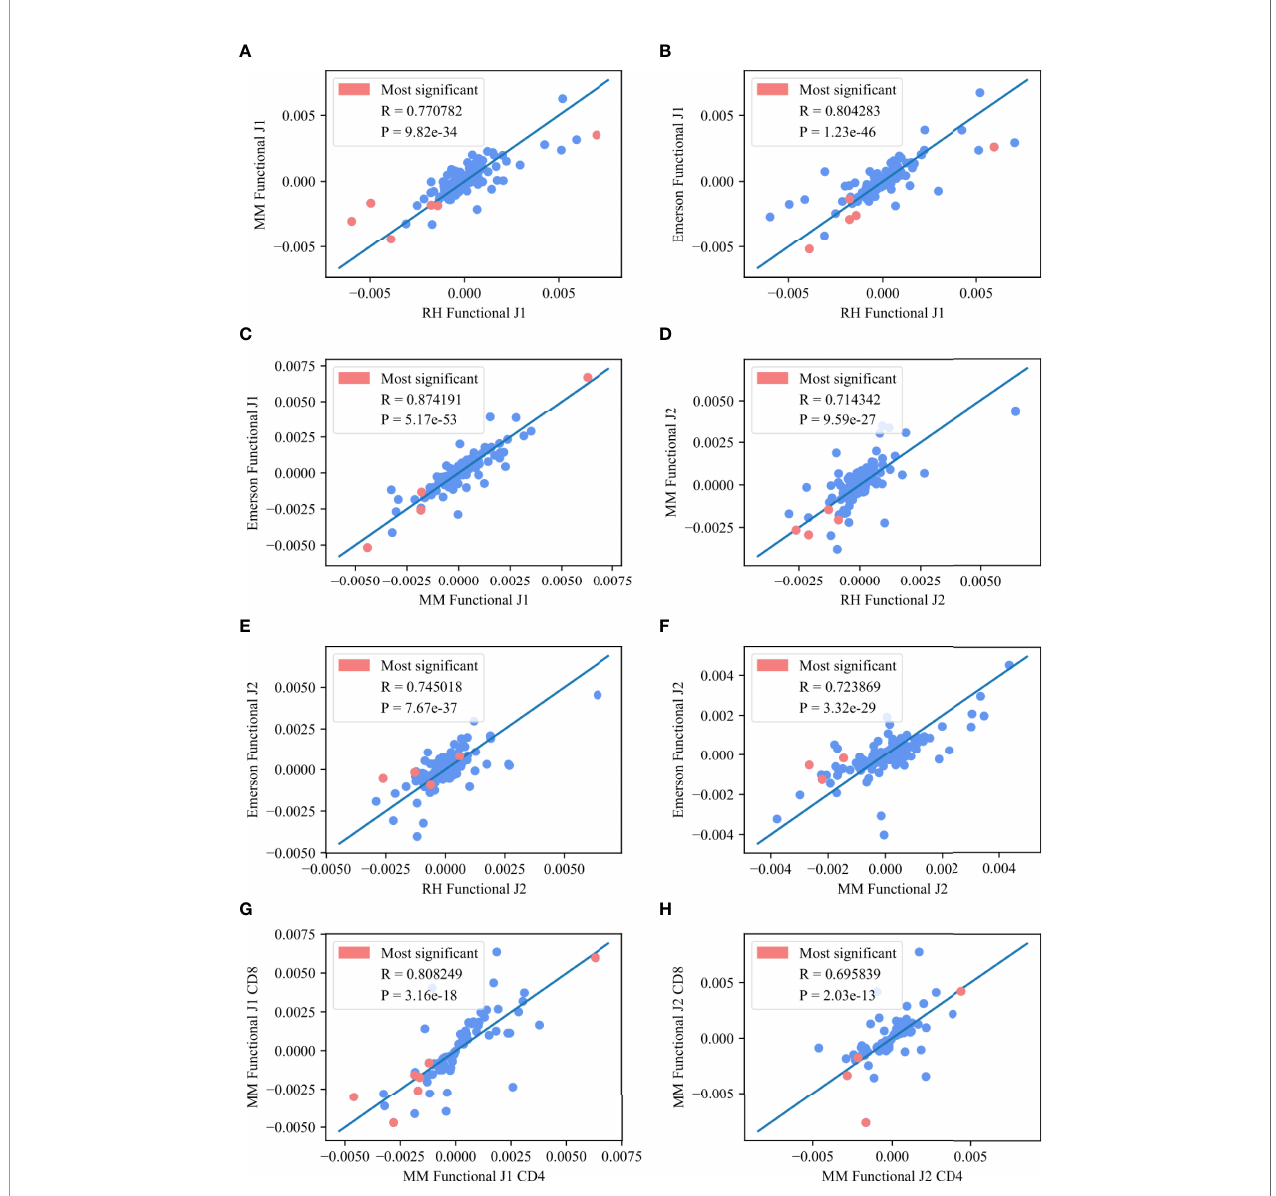
FIGURE 5 | Deviation from random pairing. (A – F) M ( V b , J b ) values between any two functional datasets for the J b 1 family gene (A – C) and the J b 2 family gene (D – F) . The pink points represent the common pairs of the 10 most signi fi cant pairs between these two datasets. (G, H) M ( V b , J b ) values for the CD8 T-cells in the MM functional for the M J b 1 family gene (G) and the J b 2 family gene (H) asa function of M ( V b , J b ) values for the CD4 T-cells in the MM functional for the same family gene. The pink points represent the common pairs of the 10 most signi fi cant pairs between these two data